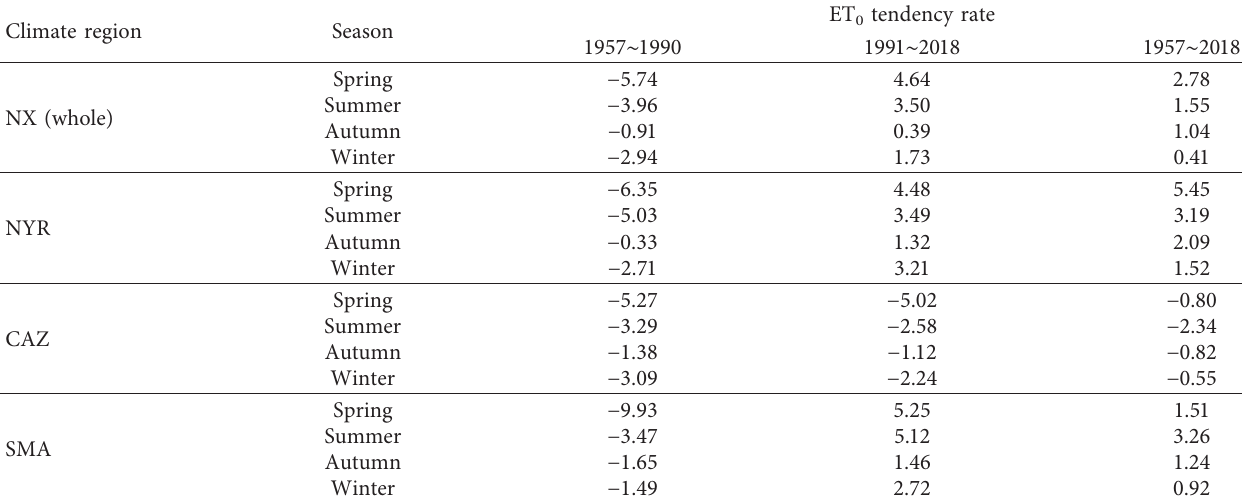
Table 5: Trend analyses of ET 0 in different seasons over the NX, NYR, CAZ, and SMA. Climate